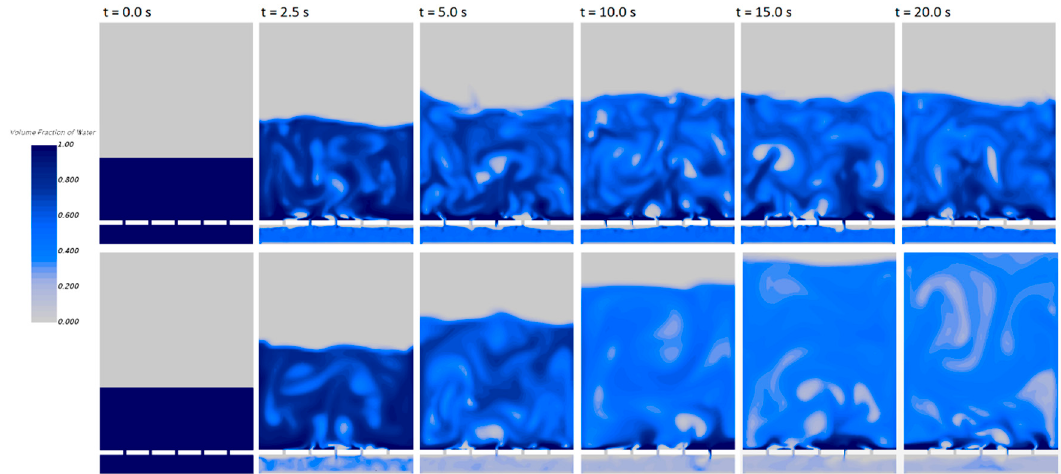
Figure 9. Volume fraction of water. ( Top ) Multi-regime interaction model, ( Bottom ) continuous regime interaction model.